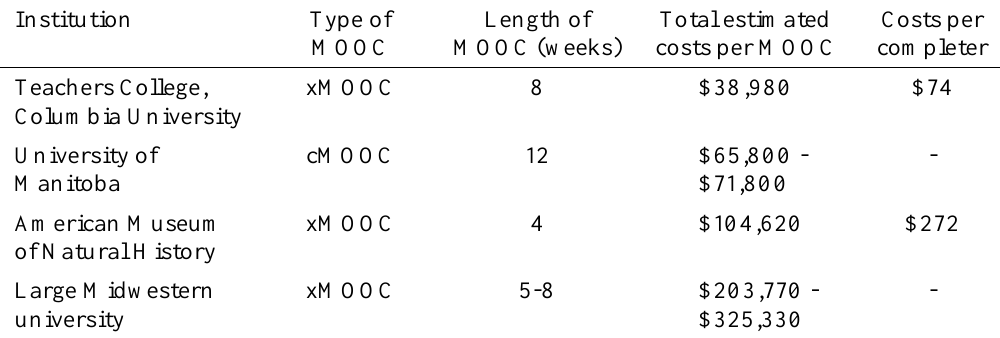
Estimated Costs of MOOC Production and Delivery at Four Institutions